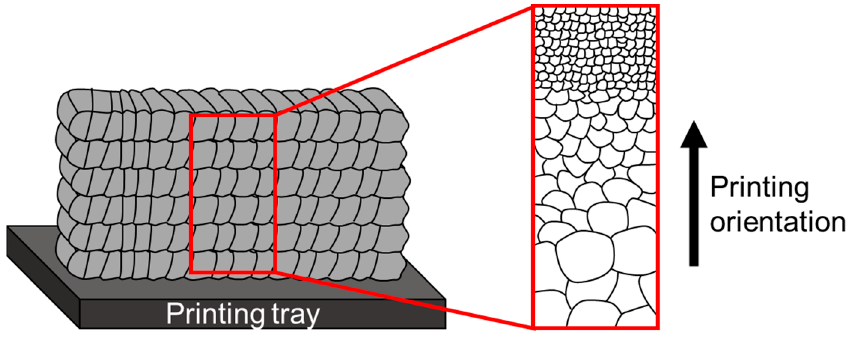
Figure 11. Schematic illustration of the microstructure characteristics as a function of printing orientation of DED-produced parts.